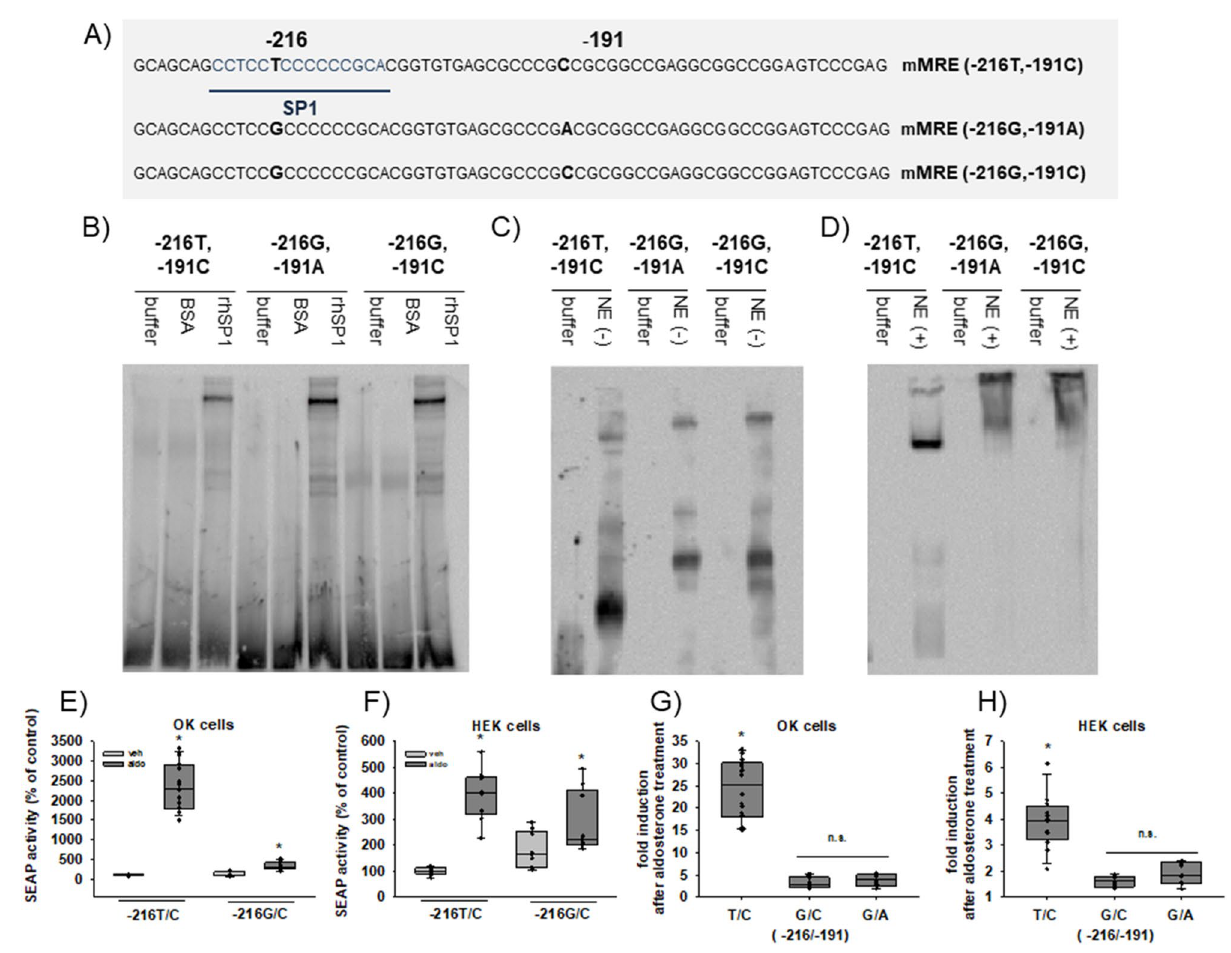
Figure 1. Effect of SNPs on MR-dependent EGFR expression and SP1 binding. ( A ) Sequences of the different mMRE variants and the SP1 consensus sequence (SP1) are depicted. ( B ) EMSAs were performed with biotinylated mMRE (-216T/-191C), mMRE (-216G/-191A) or mMRE (-216G/-191C) probes as indicated. Probes were either incubated with buffer, 300 ng BSA as control for unspecific protein interactions or with 300 ng rhSP1 (representative EMSA of N = 4). ( C ) EMSAs were performed with biotinylated mMRE (-216T/-191C), mMRE (-216G/-191A) or mMRE (-216G/-191C) probes as indicated. Probes were incubated with nuclear extracts from unstimulated hMR-transfected HEK cells (NE (−)) or buffer (representative EMSA of N = 4). ( D ) EMSAs were performed with biotinylated mMRE (-216T/-191C), mMRE (-216G/-191A) or mMRE (-216G/-191C) probes as indicated. Probes were incubated with nuclear extracts from hMR-transfected aldosterone-stimulated HEK cells (NE (+)) or buffer (representative EMSA of N = 4). ( E ) OK cells transfected with hMR and mMRE-216 (G/T) variants coupled to a SEAP reporter gene were incubated for 48 h with either vehicle or 10 nM aldosterone (N = 3, n = 6–9). ( F ) HEK cells transfected with hMR and mMRE-216 (G/T) variants coupled to a SEAP reporter gene were incubated for 48 h with either vehicle or 10 nM aldosterone (N = 3, n = 6–9). ( G and H ) Fold induction achieved by aldosterone in OK or HEK cells transfected with hMR and mMRE